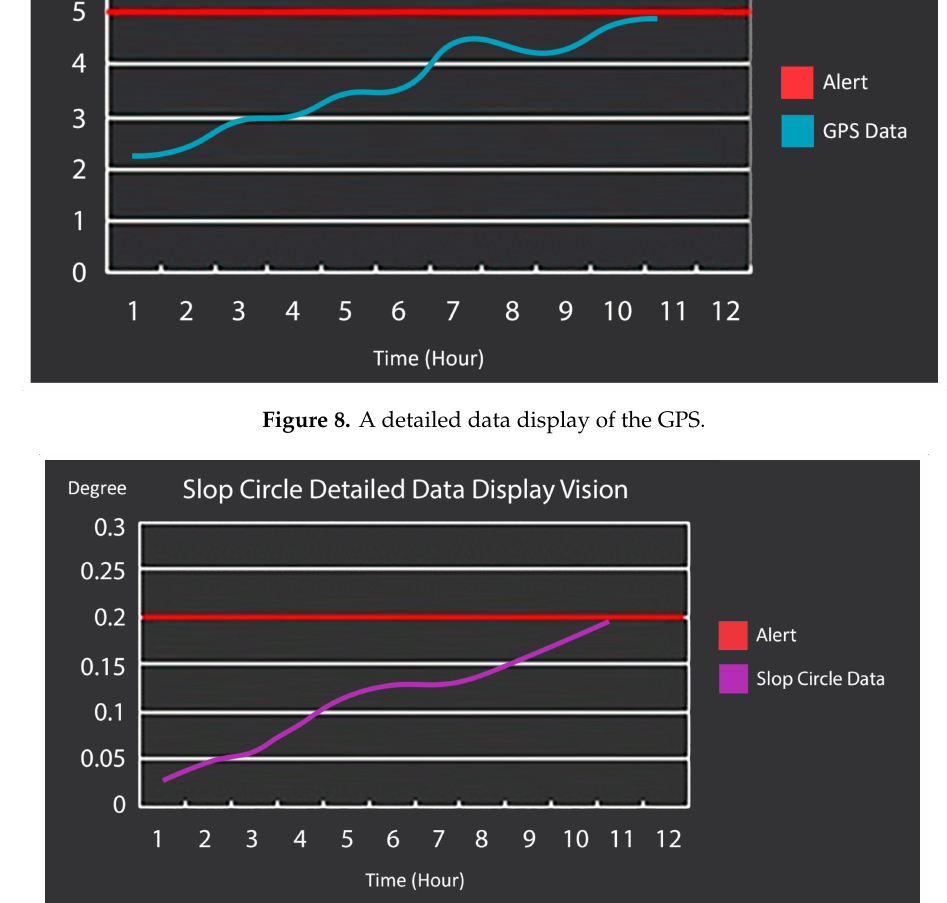
Figure 9. A detailed data display of a slop